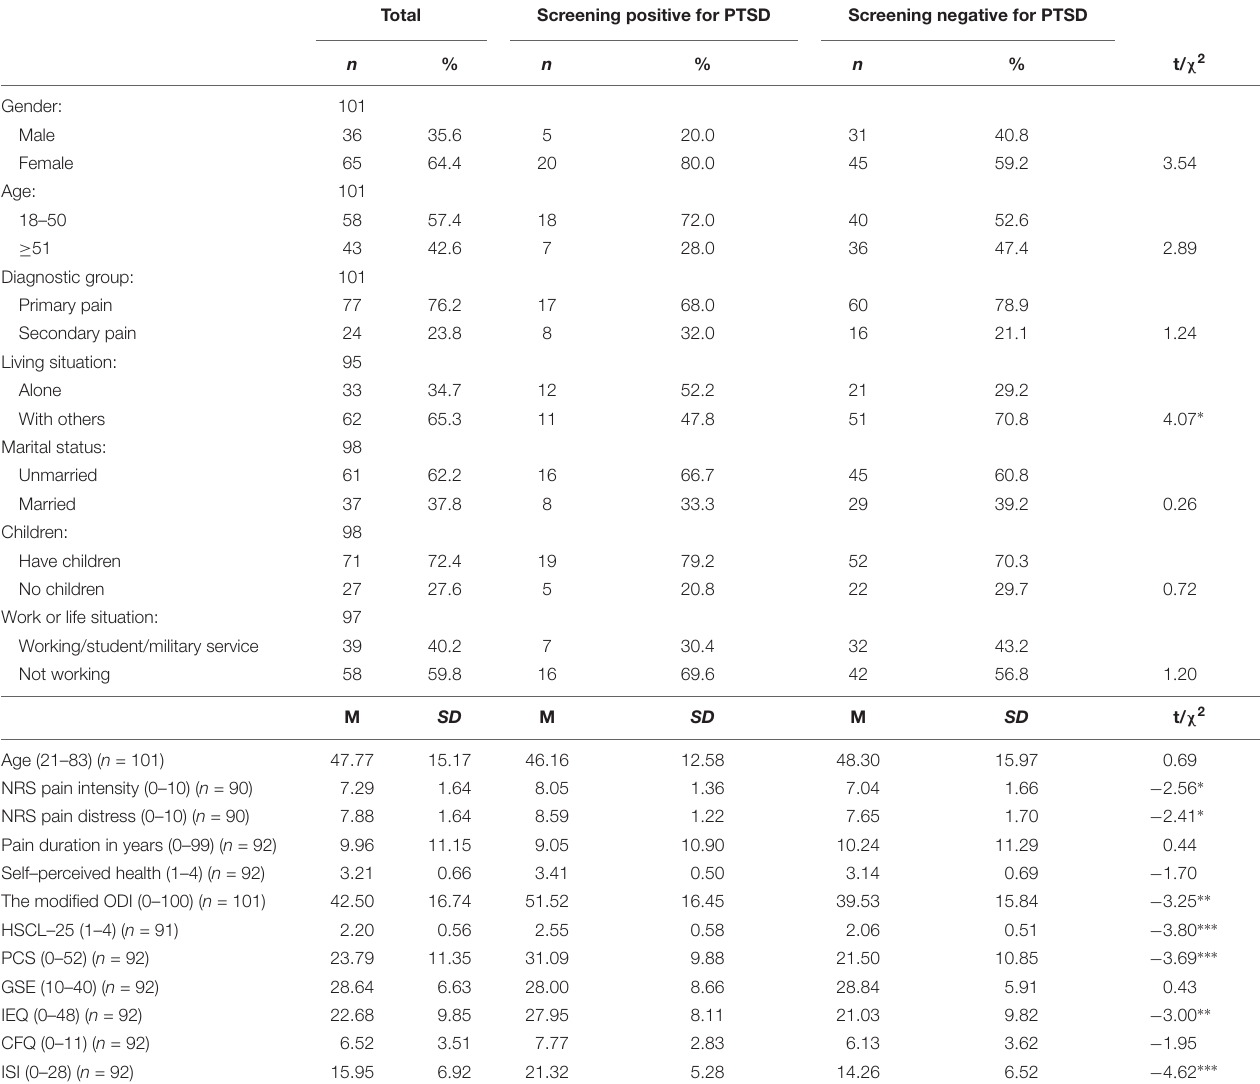
TABLE 2 | Chi-squared- and t -tests showing the differences between chronic pain patients screening positive and negative for PTSS at a level qualifying for a PTSD diagnosis in the first wave of data collection. Total Screening positive for PTSD Screening negative for